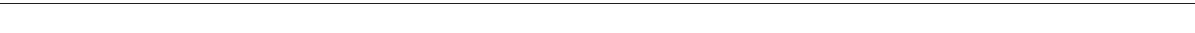
Fig. 4 Analysis of transcript features associated with Sud C1-induced intron retention. a Sequence features with signi fi cant changes between Sud C1- induced retained introns and non-differentially spliced introns. Boxplots represent the distribution of feature values (Methods) in non-differentially spliced introns (ndiff, | Δ PSI | ≤ 5) or retained introns ( Δ PIR ≥ 25) upon Sud C1 treatment, for total or BrU-pulsed RNAs. Black lines indicate median values. Outliers were discarded, boxes indicate IQR, whiskers extend to 1.5 times IQR. *; **; ***: Mann – Whitney U -test (two-sided) P value < 0.01, 0.001 and 0.0001, respectively. b Weaker drug effects in the presence of additional BP sequences. Changes in exon inclusion ( Δ PSI) or intron retention ( Δ PIR) upon Sud C1 treatment are represented for total and BrU-pulsed RNAs, for 3 ′ ss containing a single (1 BP) or multiple (BPs) matches of the BP consensus YNYYRAY within a window of 100 nucleotides from the 3 ′ ss. Exon skipping corresponds to negative Δ PSI values, while intron retention to positive Δ PIR differences. Black lines indicate median values. *; **; ***: Mann – Whitney U -test (two-sided) P value < 0.01, 0.001 and 0.0001, respectively. c Working model summarizing sequence features that enhance or reduce the inhibitory effects of Sud C1 on 3 ′ ss recognition. BP (YUNAY), Py-tract (Y), and AG dinucleotide are indicated in the pre-mRNA, while the BP recognition region (GUAGUA) is indicated in U2 snRNA. SF3B1 and p14 protein components of U2 snRNP are positioned close to the BP/U2 snRNA base paired region but are proposed to adopt an alternative conformation in the presence of the